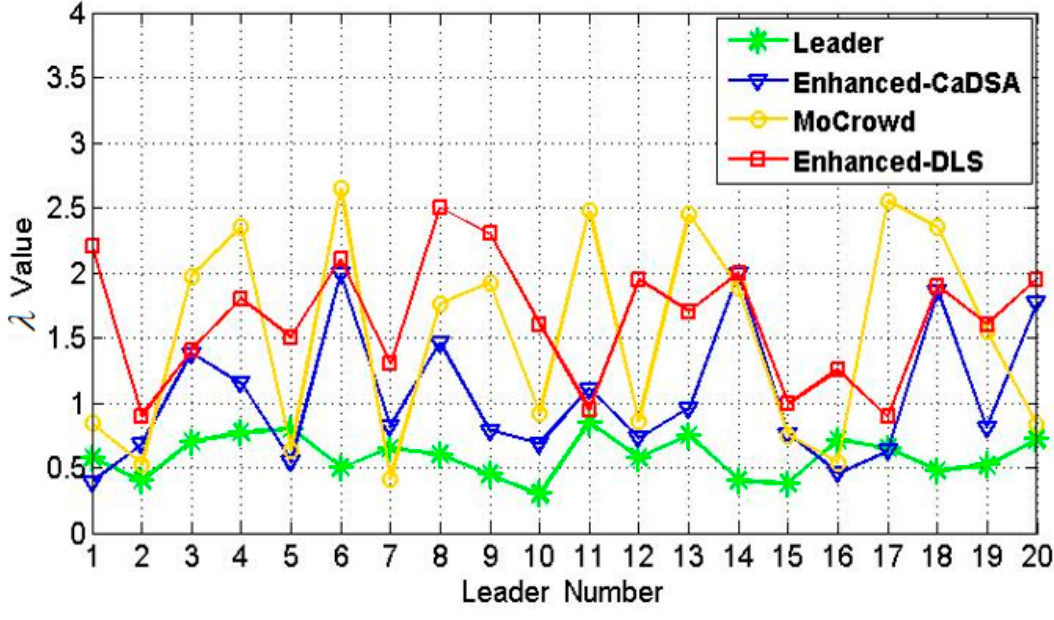
Figure 13. λ values for 20 Leaders, k = 6. λ Figure 13. values for 20 Leaders, k = 6 .